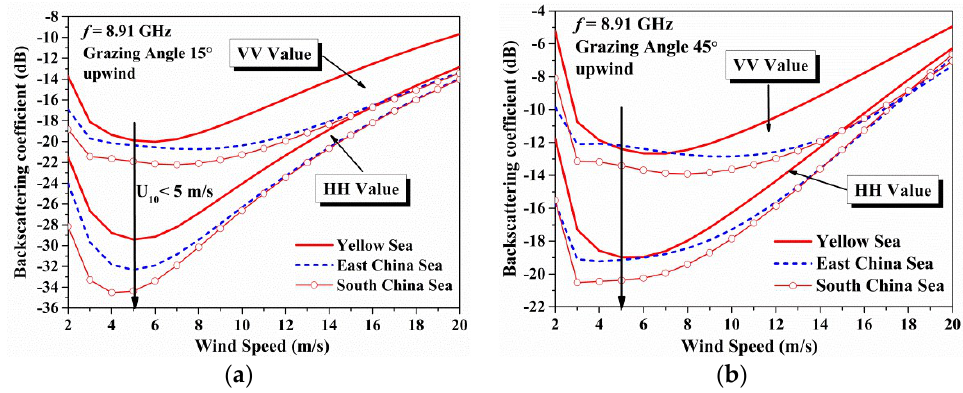
Figure 11. The figures show the wind speed variation of the co-polarization backscattering coefficients in different seas: ( a ) At 15° of grazing angle; ( b ) At 45° of grazing angle.